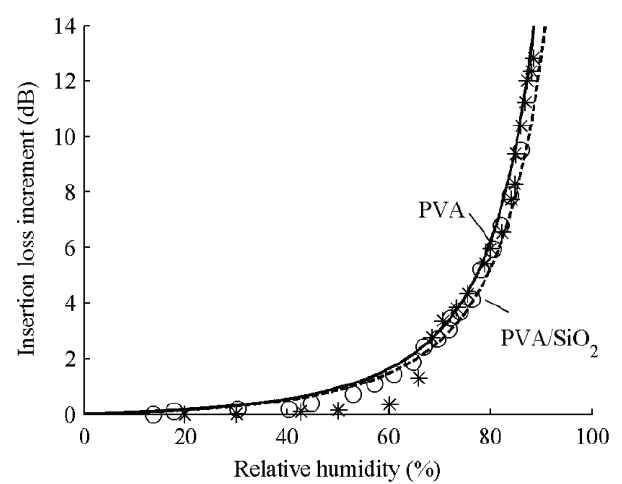
Figure 5. Insertion loss shifts versus relative humidity for ST-90°X quartz substrate/PVA and ST-90°X quartz substrate/SiO 2 /PVA